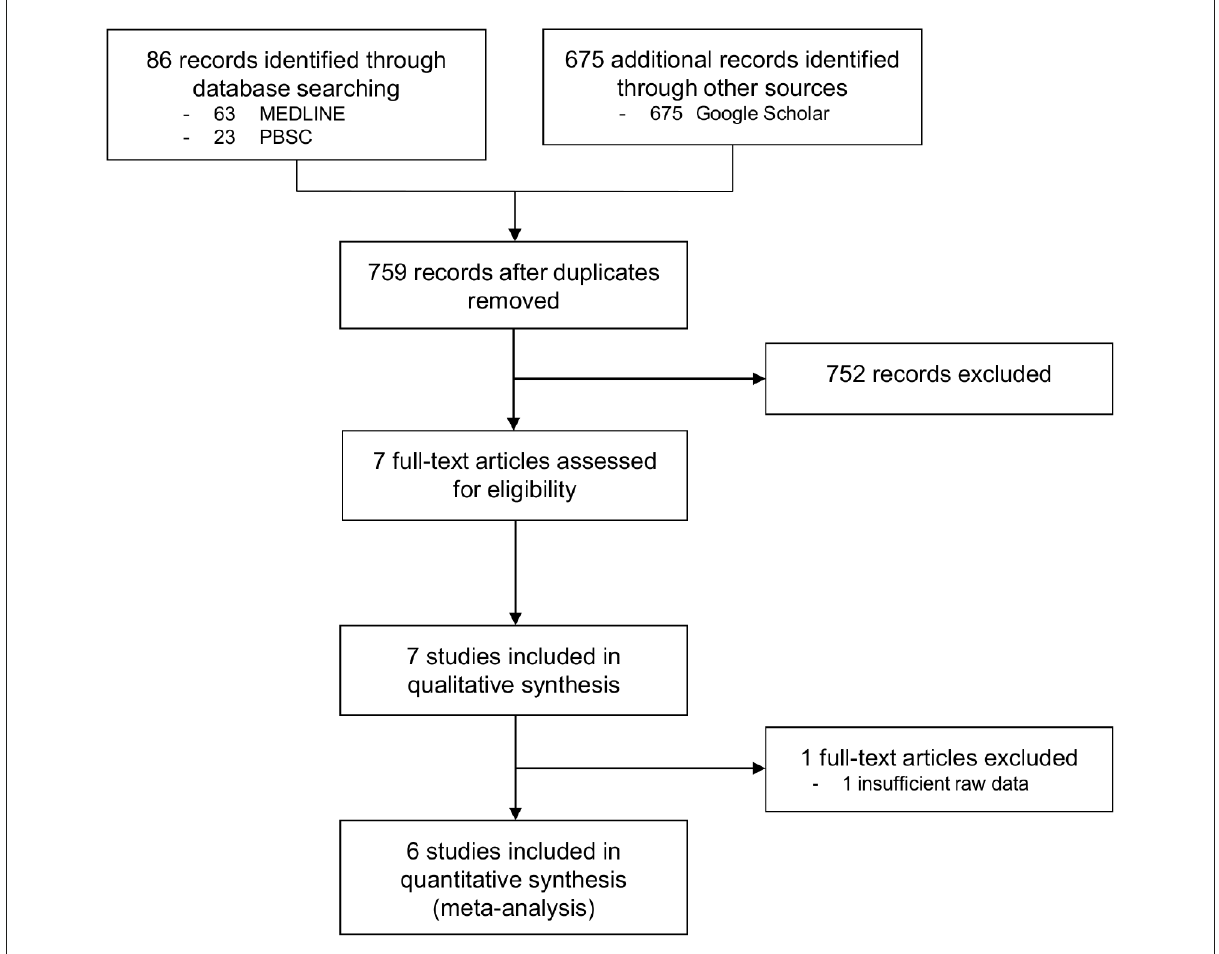
FIGURE1 Flowchart of the results of the literature